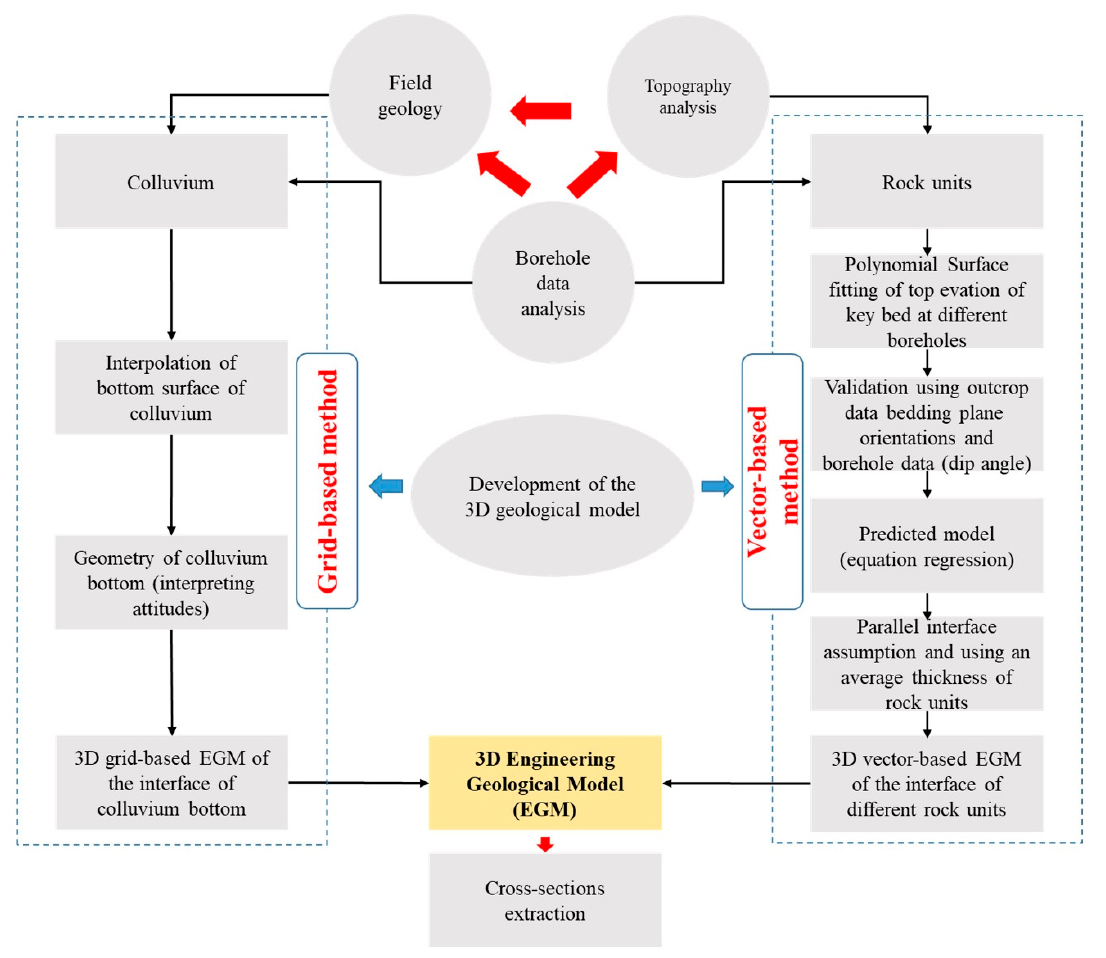
Figure 2. Workflow for development of a 3D engineering geological model (EGM).